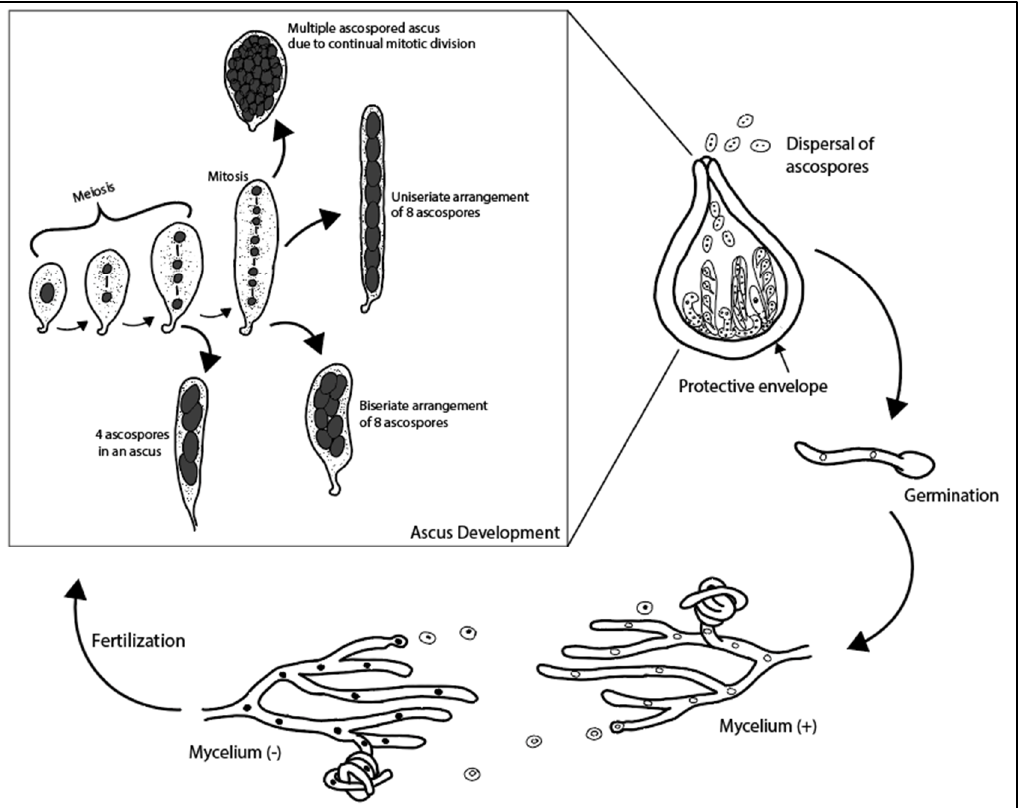
Figure 5. Development of ascospores (adapted after Peraza Reyes and Berteaux-Lecellier [46]). Top right corner displayed the formation of fruitbodies with asci (adapted after Bell [16]). An ascospore is a spore contained, or produced from, an ascus. The ascogonium is the female mating type that contains the gametic nuclei. The process of meiosis is cell division, reducing chromosomes in gametes. The process of this takes place inside a protective envelope through which the ascospores are discharged from the ostiole.